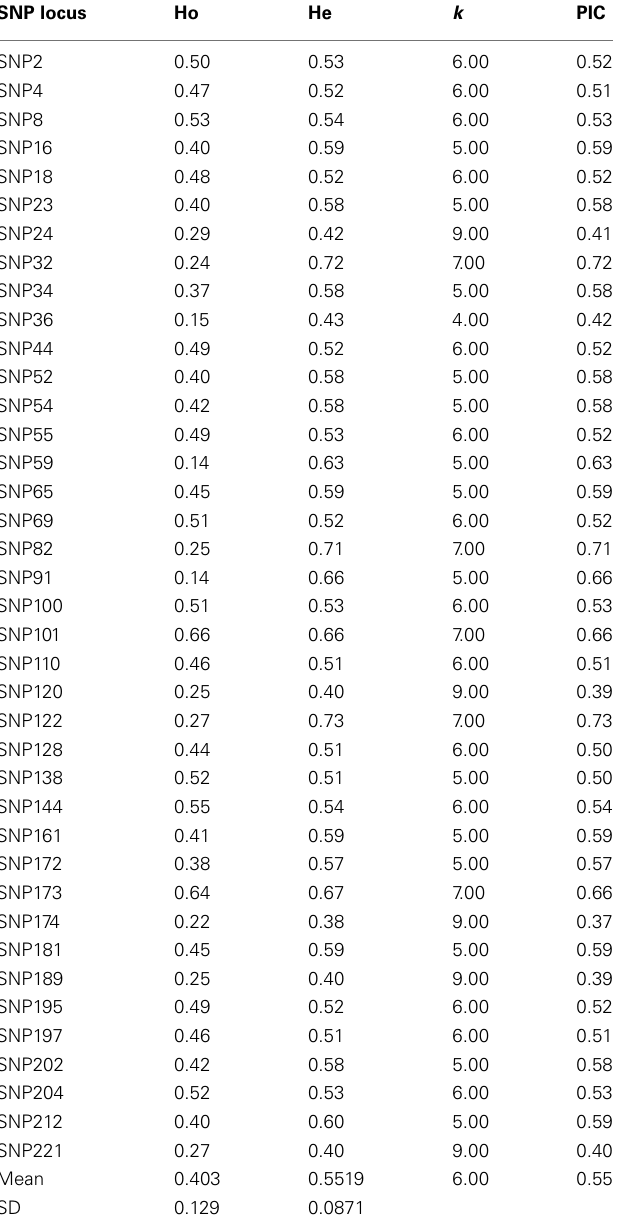
Table 4 | SNP locus obtained from the sweet cherry genome analyzed in the sweet cherry cultivars studied, number of alleles obtained ( k ), observed (Ho), expected heterozygosity (He), and polymorphism information content (PIC).